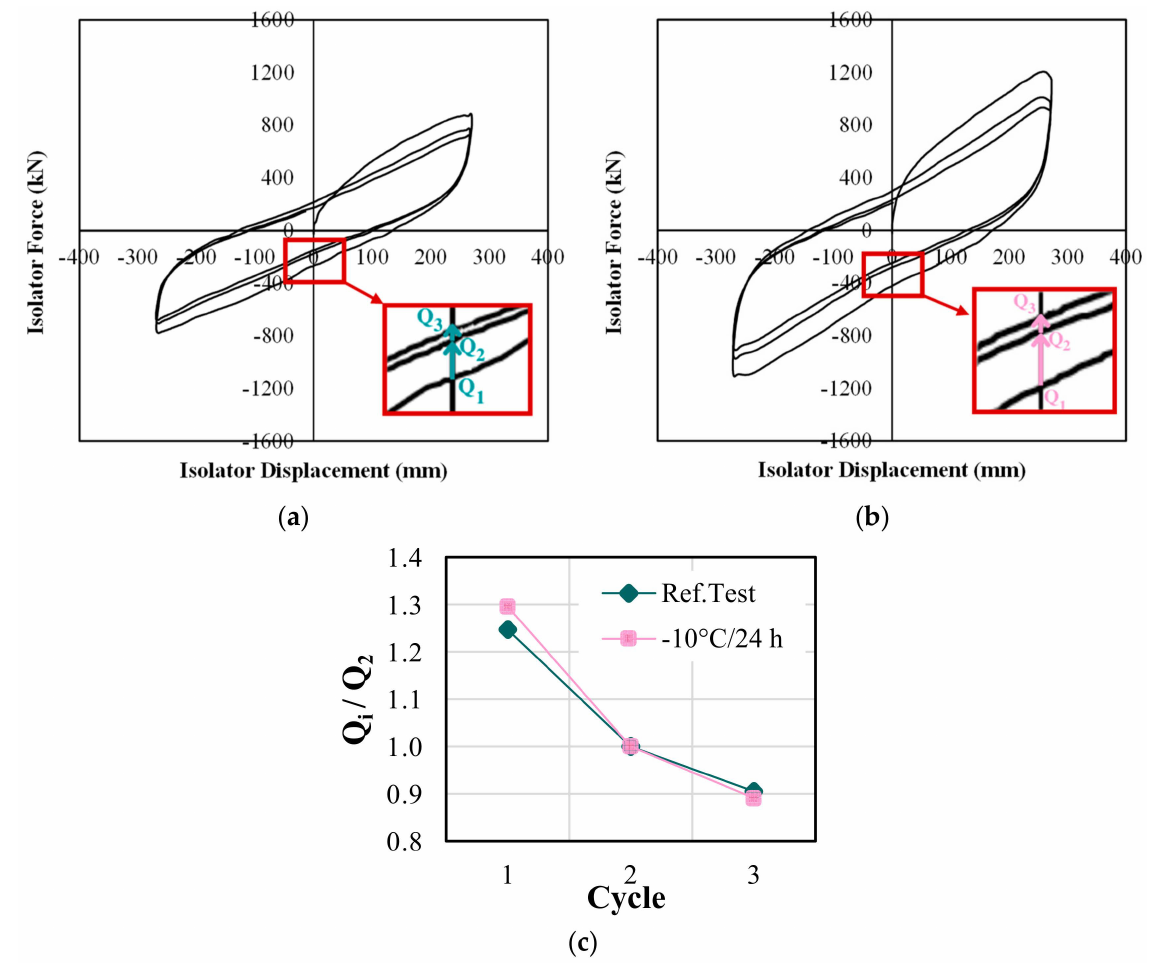
Figure 12. Force-displacement curves of the LRB for 134% shear strain and 0.5 Hz loading frequency ( a ) reference test ( b ) 24 h exposure time at − 10 ◦ C, ( c ) ratio of characteristic strength each cycle to that of the second